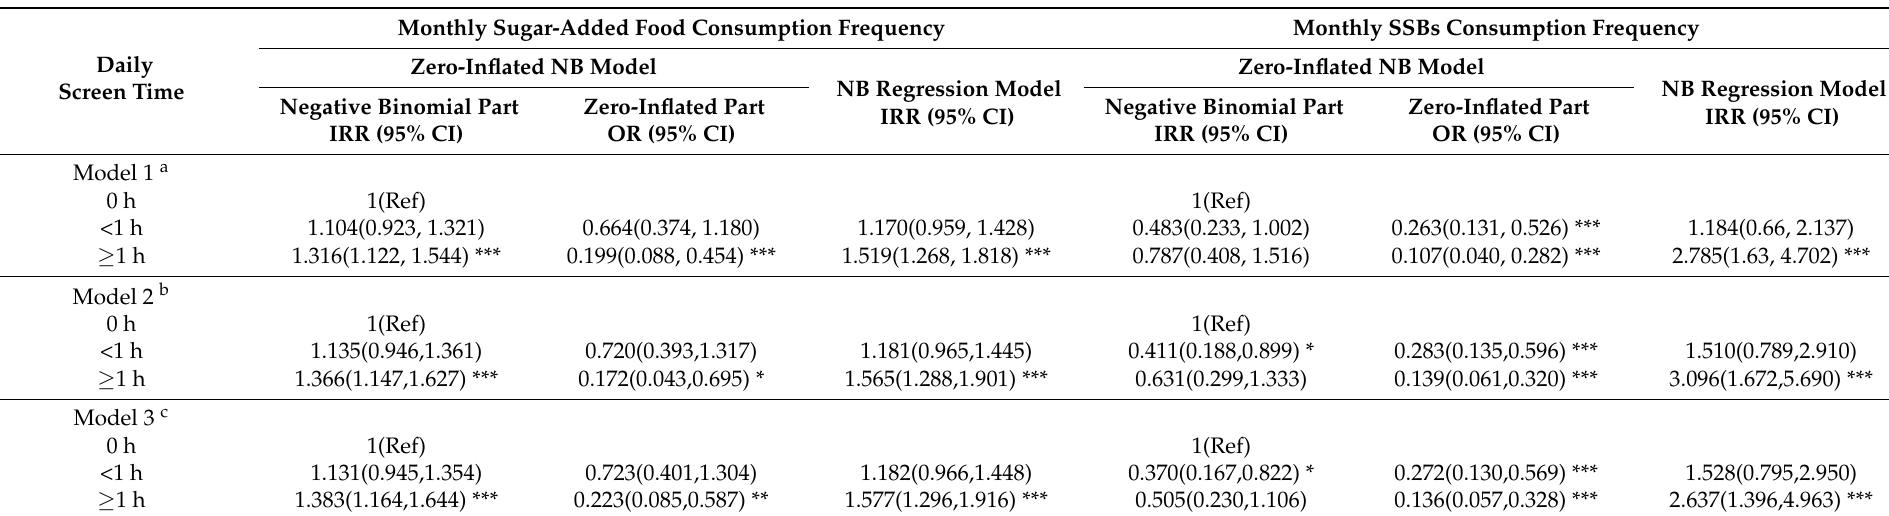
Table 4. Associations between daily screen time and the consumption frequency of products with added